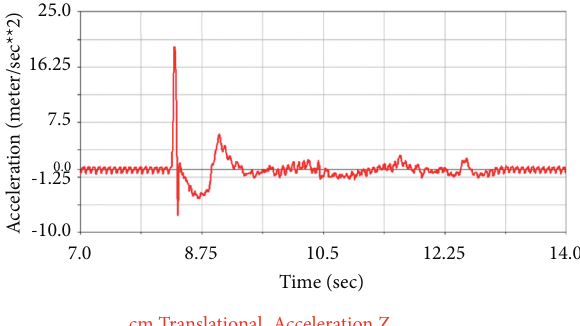
Figure 15: Vertical acceleration of centroid in the process of crossing a vertical wall.